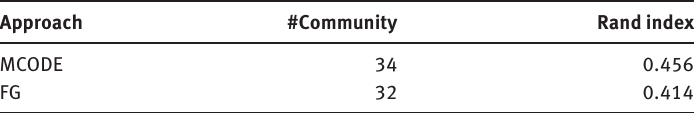
Table 6. Results Obtained by Applying MCODE and FG to the uFDN of